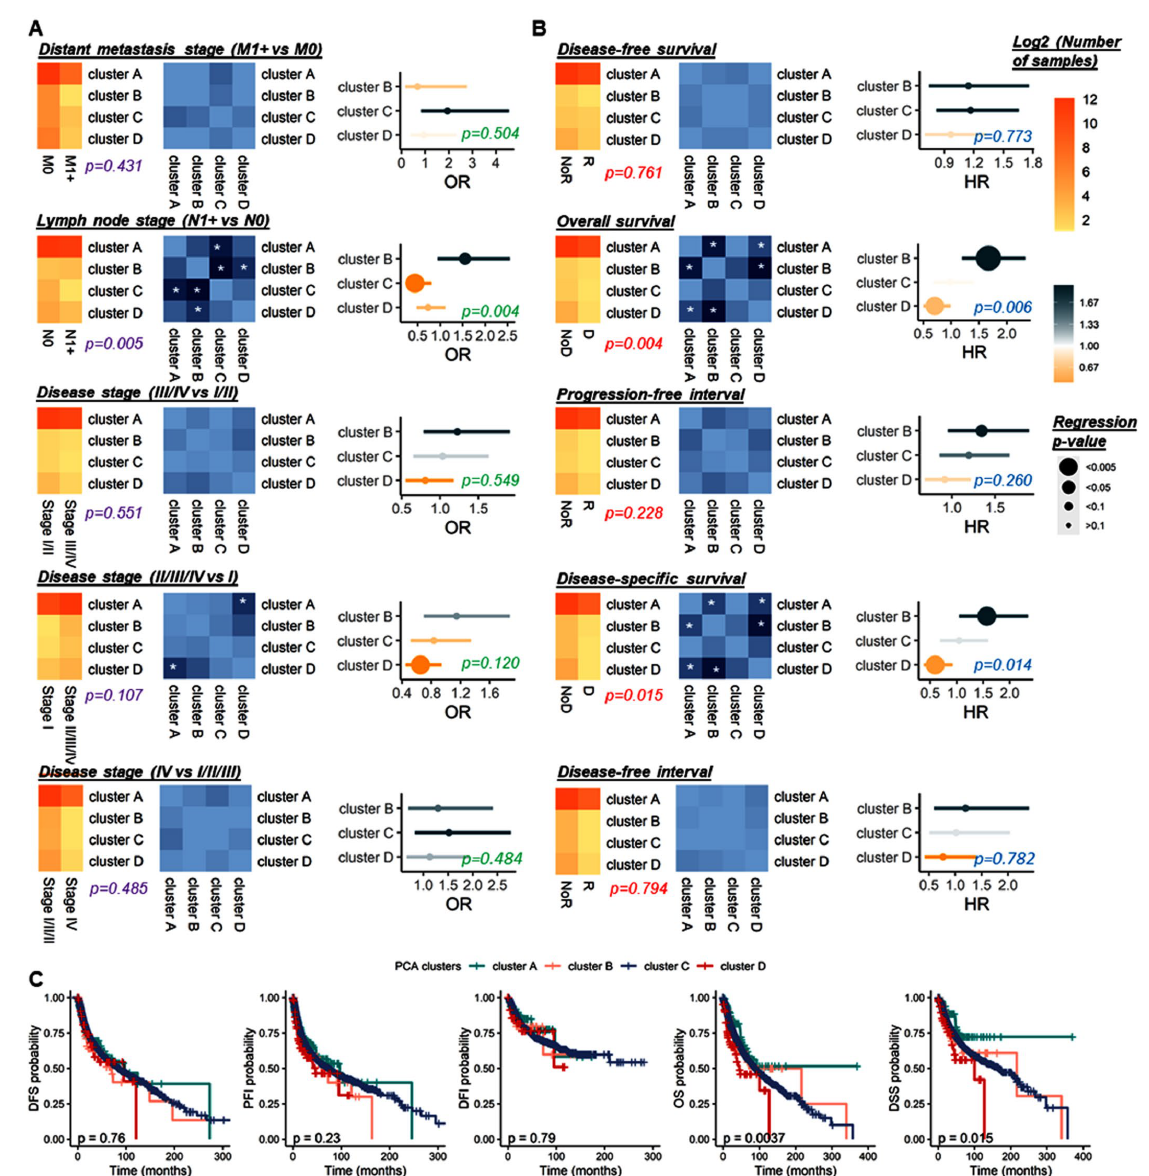
survival (Figure 12B). Cluster B presents a significant outcome than cluster A (OS, p = 0.002); DSS, p = 0.027), and cluster D (OS, p = 5.04 × 10 − 4 ; DSS, p = 0.001), as well as cluster A compared to cluster D (OS, p = 0.048; DSS, p = 0.022) (Figure 12C).